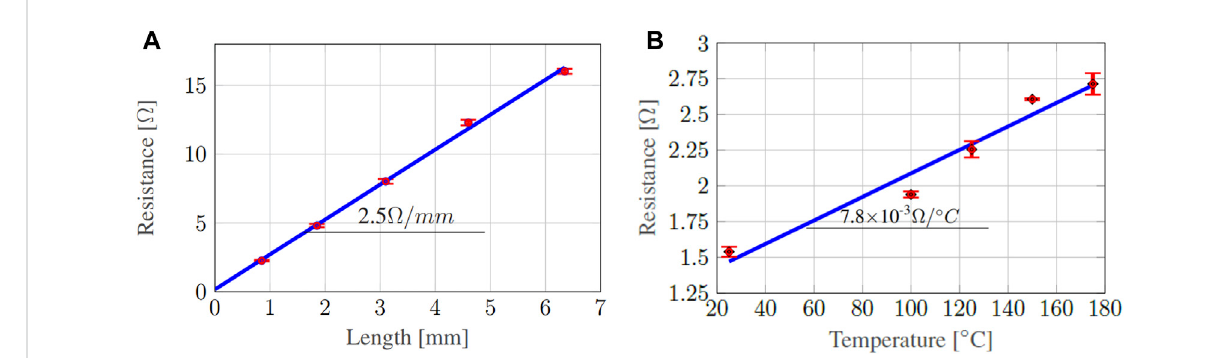
FIGURE 2 (A) Relationship between segment length and measured resistance. Graph obtained from the slopes of Supplementary Figure S4. The slope of the straight line that represents the linear resistivity of the trace is indicated. (B) Linear relationship between temperature and measured resistance. The slope of the straight line that represents the thermal coef fi cient of the trace is indicated.